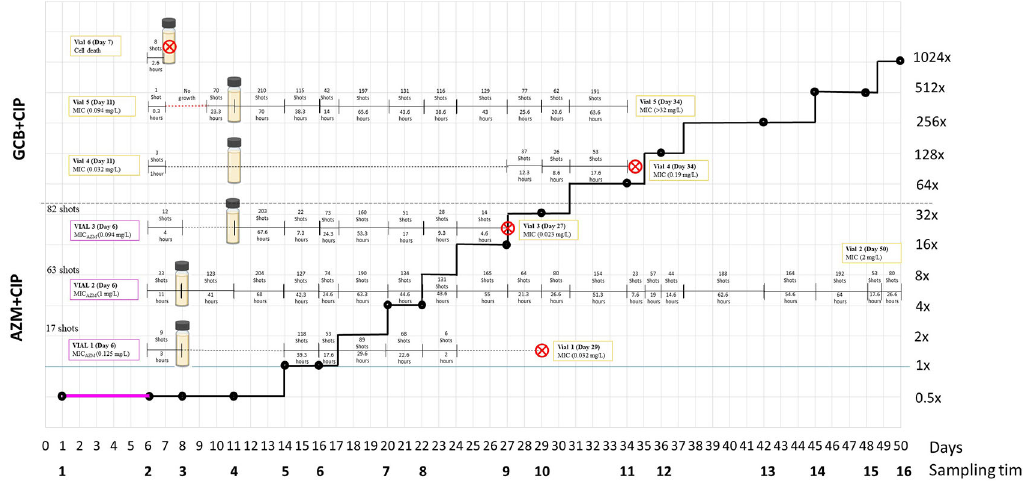
Figure 2. Visual evolution of the concentration of ciprofloxacin in the reservoir, presented as a black line with dots that mark the sampling time, and the life expectancy of the cultures in each vial. Pink boxes provides information about the AZM MIC after 5 days of AZM exposure in vials (Condition 2). The yellow boxes provide information about the CIP MIC in all vials from both conditions. The crossed red circle represents cell death or contamination. X-axis denotes the days and sampling time-points. Y-axis denotes the ciprofloxacin concentration in the reservoir expressed as the multiples of the initial MIC value of CIP. Contaminants isolated on blood agar were presumptively identified by a negative oxidase reaction. (AZM: Azithromycin; MIC: Minimum inhibitory concentra- tion; CIP: Ciprofloxacin).